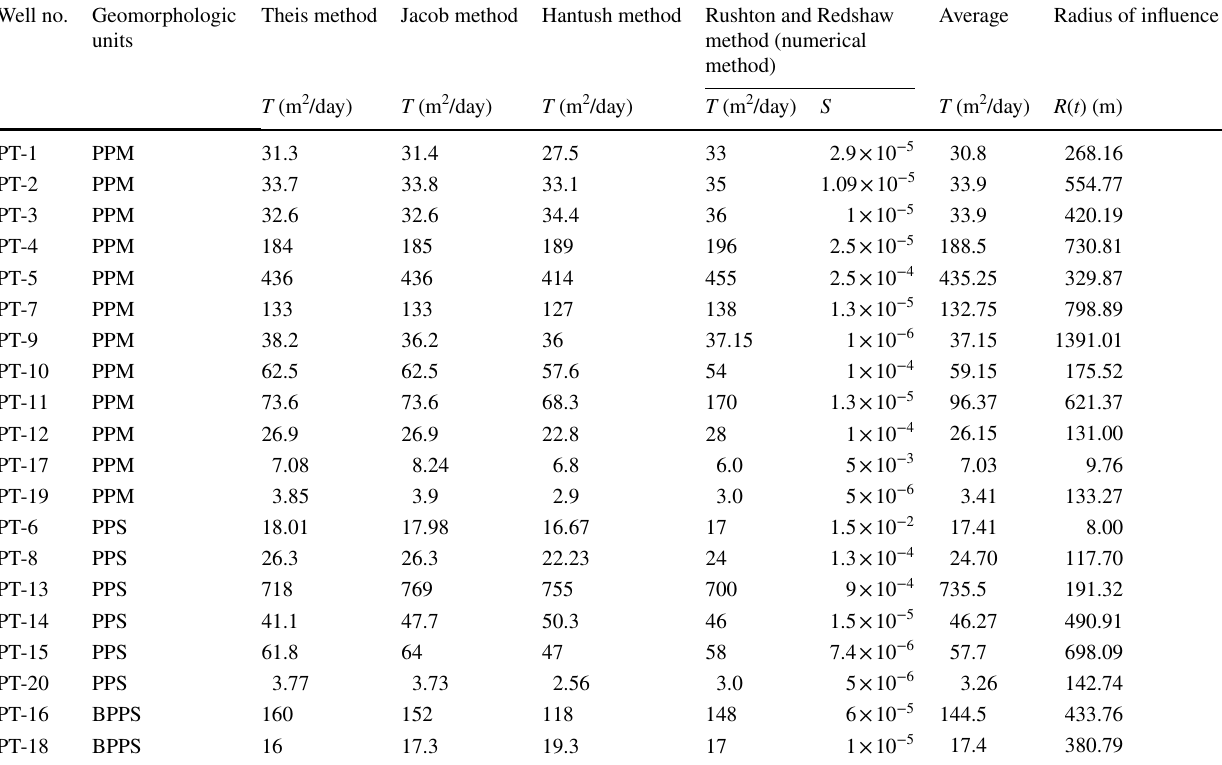
Table 2 Transmissivity ( T ), storativity ( S ), and radius of influence ( R ) of aquifers as determined by various methods Well no. Geomorphologic